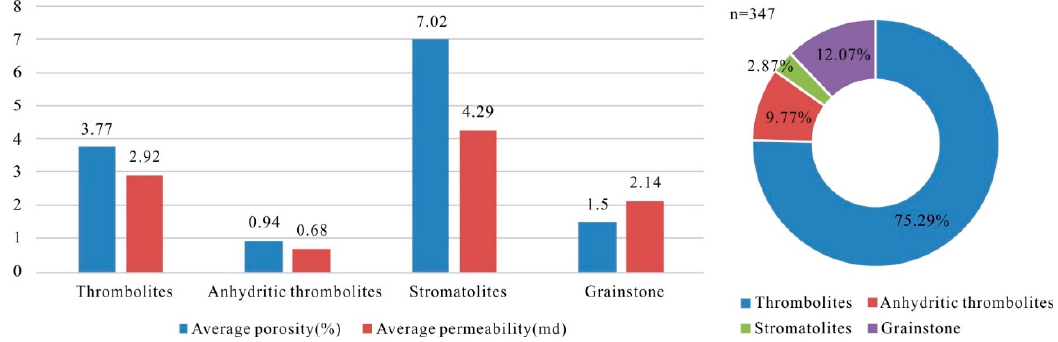
Figure 6. Average porosity, average permeability and frequency of different lithofacies in the Leikoupo Formation. The number of samples is 347.